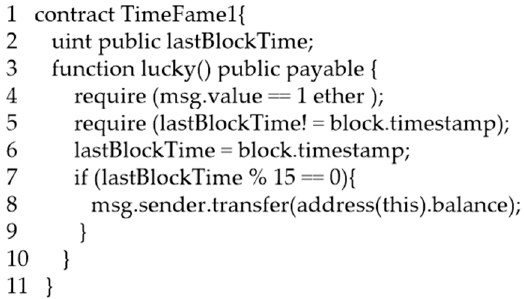
Figure 3. Timestamp dependence code of contract TimeFame1.